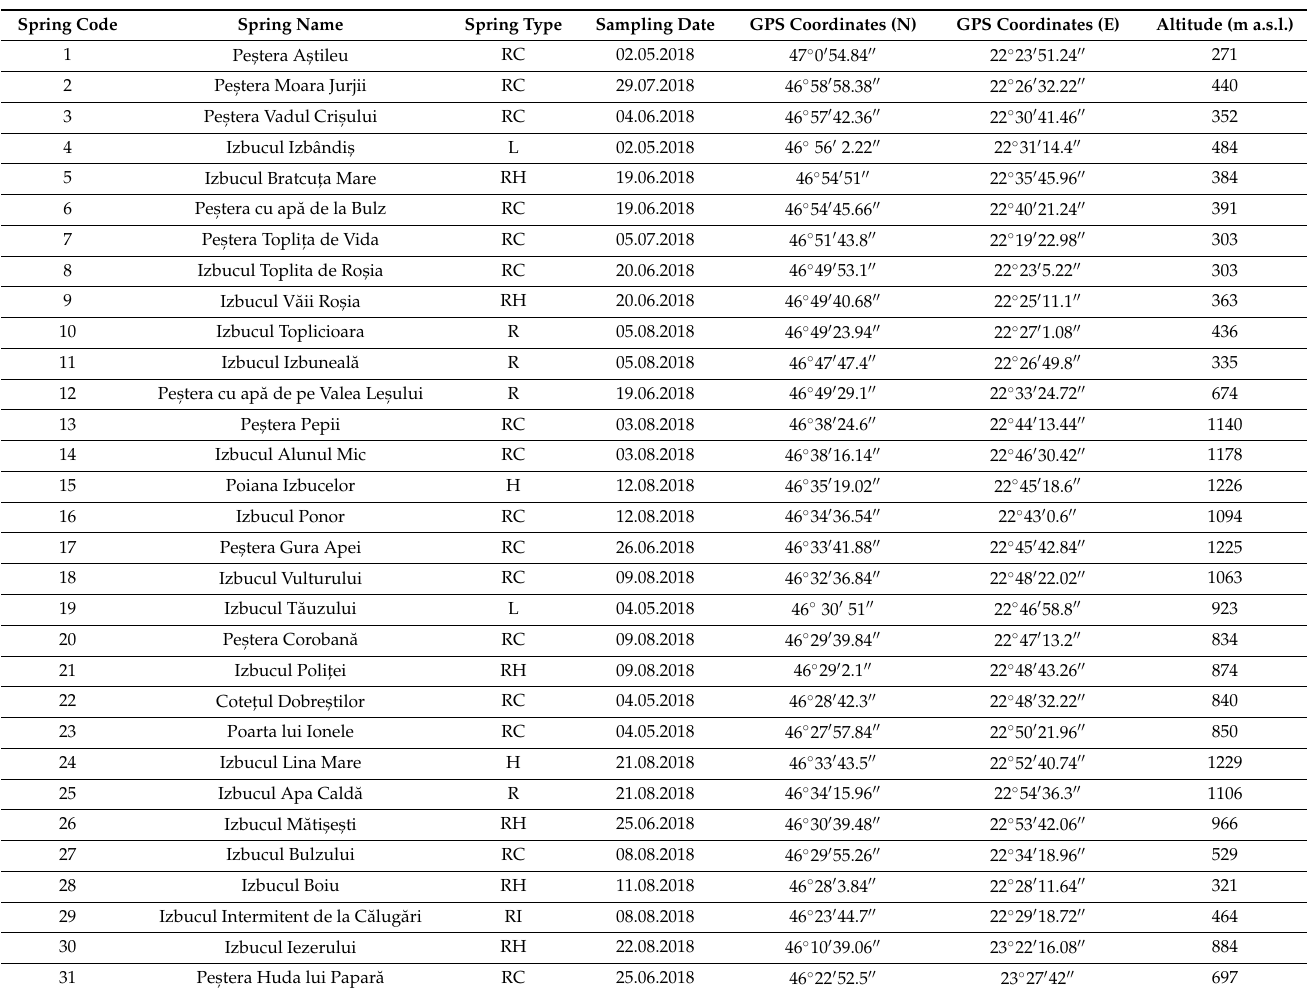
Table 1. Locations and sampling dates for the 31 springs considered for the present study (spring type: H—helocrene; L—limnocrene; R—rheocrene; RC—rheocrene cave; RH—rheohelocrene; RI— rheocrene